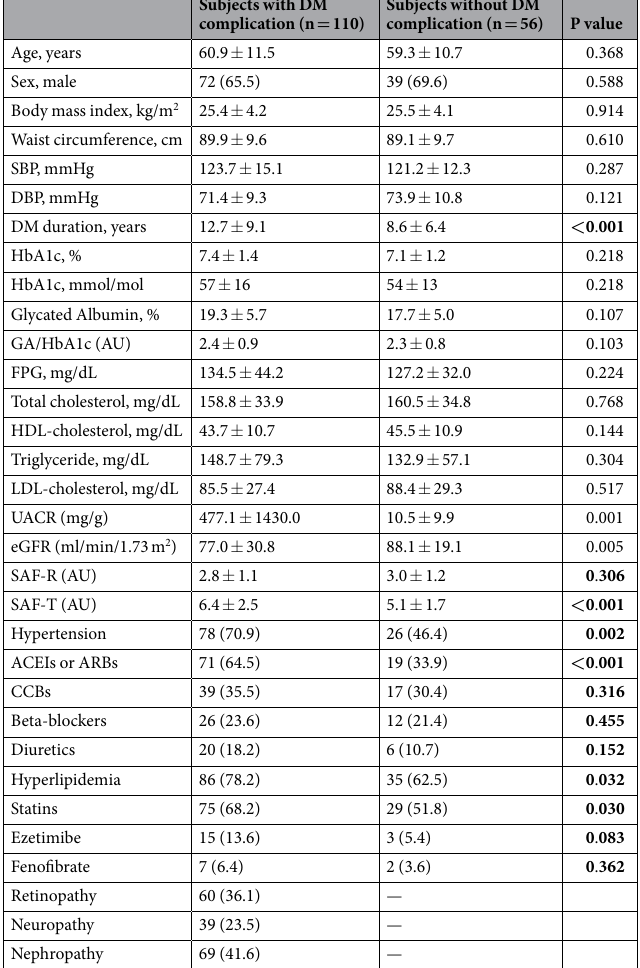
— Table 1. Baseline characteristics of patients according to the complication status. Data are expressed as the mean ± standard deviation (SD) for continuous variables and percentage (%) for categorical variables. SBP, systolic blood pressure; DBP, diastolic blood pressure; AU, arbitrary unit; FPG, fasting plasma glucose; HDL, high-density lipoprotein; LDL, low-density lipoprotein; UACR, urine albumin-to-creatinine ratio; eGFR, estimated glomerular filtration rate; SAF-R, reflected skin auto-fluorescence on the volar side of the forearms; SAF-T, transmitted skin auto-fluorescence in the 1 st interossei muscle of the hand; ACEIs, angiotensin converting enzyme inhibitors; ARBs, angiotensin receptor blockers and CCBs, calcium channel